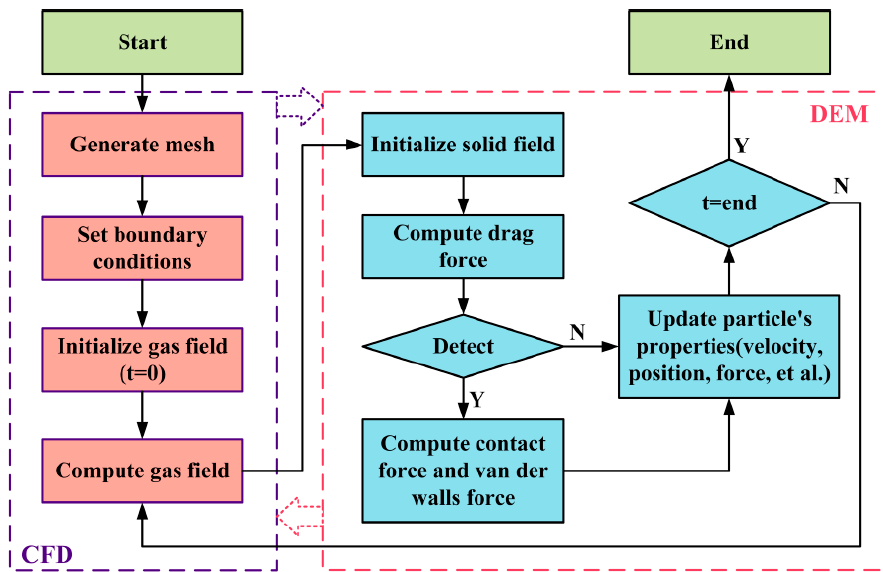
Figure 1. Flowchart of the CFD-DEM coupling.